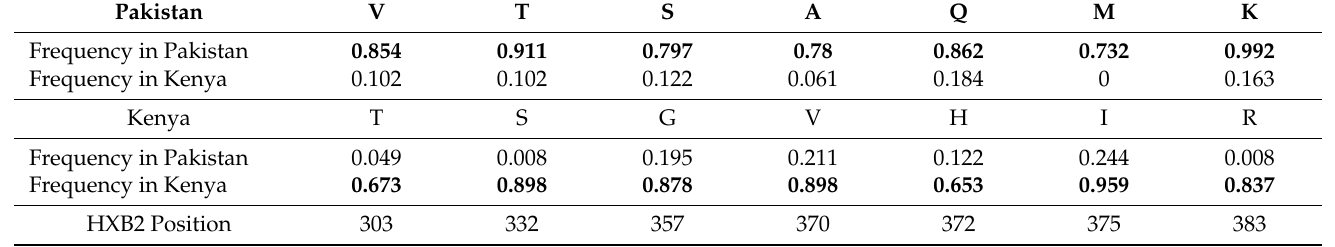
Table 2. Signature Variation Pattern of HIV-1 Sub-Subtype A1 in Pakistan in comparison with the Kenyan reference dataset. The predominant amino acid variant in the Pakistani and Kenyan reference dataset is represented in 1 and 4 rows of the table, respectively. The frequencies of each amino acid variant are mentioned below the variant, whereas the highest frequencies of variants in the Pakistani and Kenyan reference dataset are shown in bold. The position of the amino acids concerning the HXB2 is mentioned in the last row.